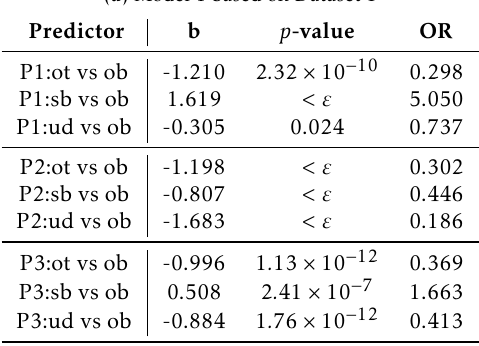
Table 4. Results of the multinomial logistic regression conducted on the behavioral pattern as the predictor of participants’ self- reported trust.